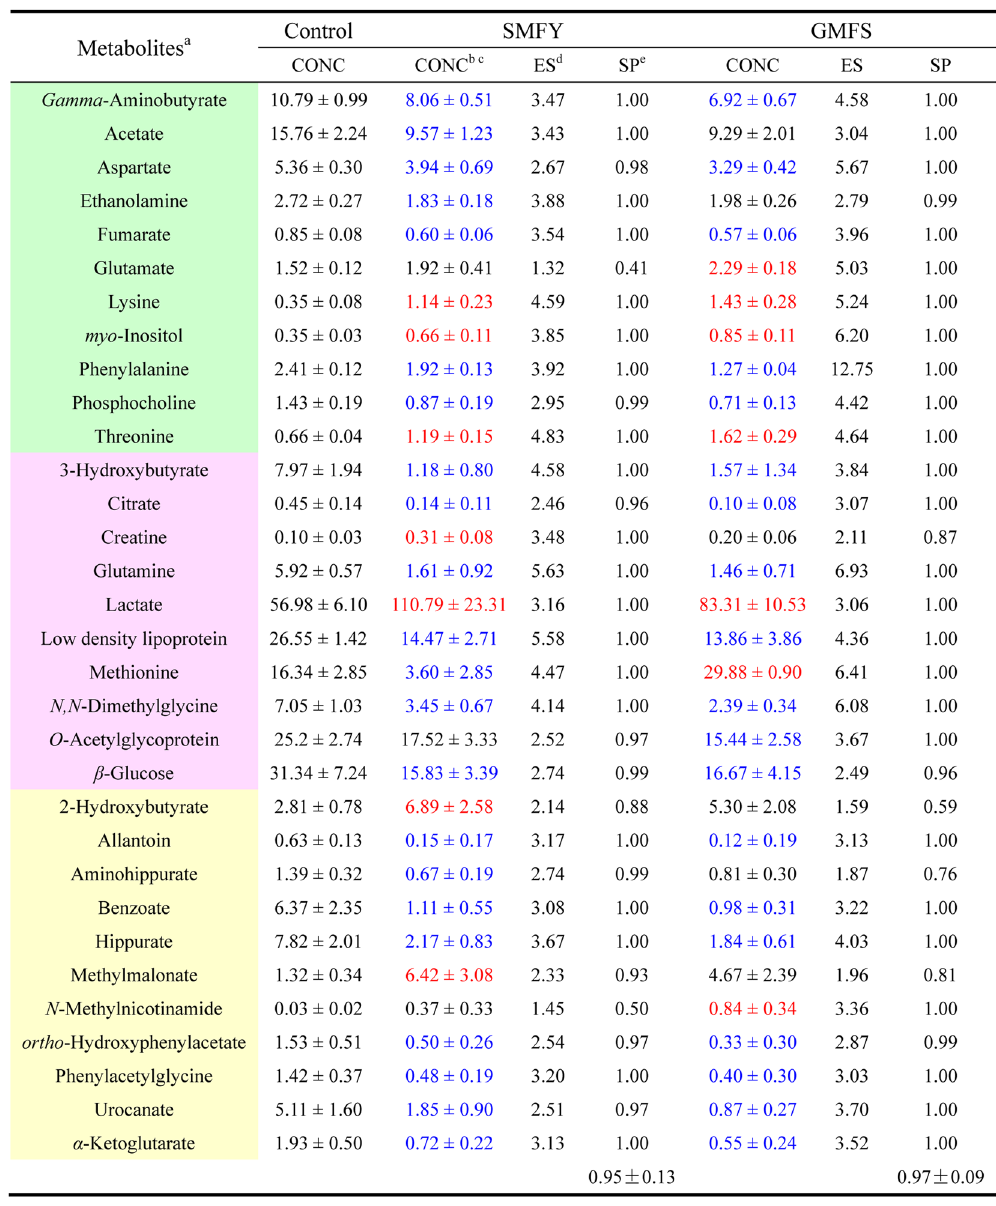
Figure 7. The post hoc power analysis of the selected metabolites calculated in G * power. ( a ) colour coded according to the different bio-samples, (light green), (soft red), and (light yellow) present cortex extract, serum, and urine respectively. ( b ) The relative concentration (percentage of the normalized integrals, mean ± SD). ( c ) Red coloured numbers denote significant increase whereas the blue coloured ones indicate significant decrease and the black coloured ones denote no significant changes in the EA-treated group (i.e., SMFY and GMFS) compared to the control group. The criteria of selection are as shown in Table S1. ( d ) The effect size computed based on the standardized mean difference between the EA-treated group (i.e., SMFY and GMFS) and the control group in G * power. ( e ) The statistical power calculated as a function of critical significance level ( α = 0.01), given sample size ( n = 8), and obtained variable effect size in G *